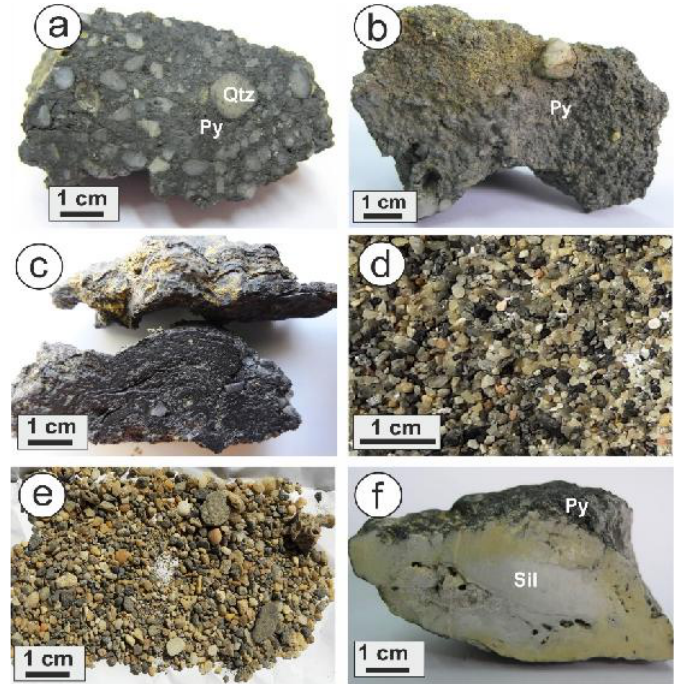
Figure 4. Representative examples of the different mineralization types (samples of sulfide‐mounds and metalliferous sediments correspond to hydrothermal features shown in Figure 3): ( a , b ) Hand specimens of sulfide‐coated mounds; pyrite (Py) cements clastic quartz (Qtz) grains (ML04 and ML05 respectively); ( c ) hand specimen of sulfide mound consisting of colloform cinnabar‐bearing pyrite/marcasite layers cementing clastic quartz grains (ML03); ( d , e ) unconsolidated metalliferous sediments from areas with active fluid discharge (ML04A and ML04B, respectively); ( f ) fragment of metalliferous sediment, where sulfide encrustations composed of pyrite surround opaline silicified rocks (Sil) (ML06).